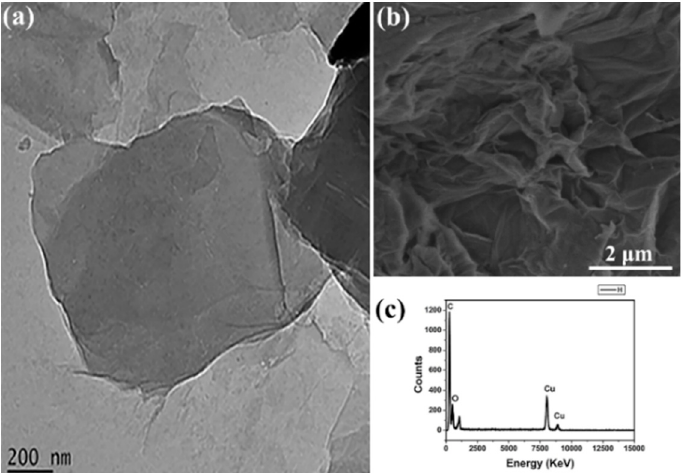
Figure 3. High-resolution transmission electron microscopy (HRTEM) image ( a ), scanning electron microscope (SEM) image ( b ) and energy-dispersive spectroscopy (EDS) spectrum of GO ( c ), respectively.